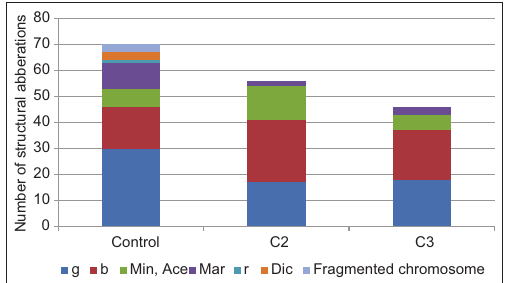
FIGURE 1. Frequency of the structural aberrations. Cell culture C2 was incubated with met‑enkephalin and alpha‑ACTH 1‑13, in concentrations of 1.2 µg/ml and 0.24 µg/ml, respectively, while C3 was incubated with met‑enkephalin and alpha‑ACTH 1‑13, in concentrations of 120 µg/ml and 24 µg/ml, respectively. Ace, acentric fragments; Min, minute acentric fragments; r, ring chro‑ mosome; Dic, dicentric chromosome; b, breaks; g, gap; Mar, marker